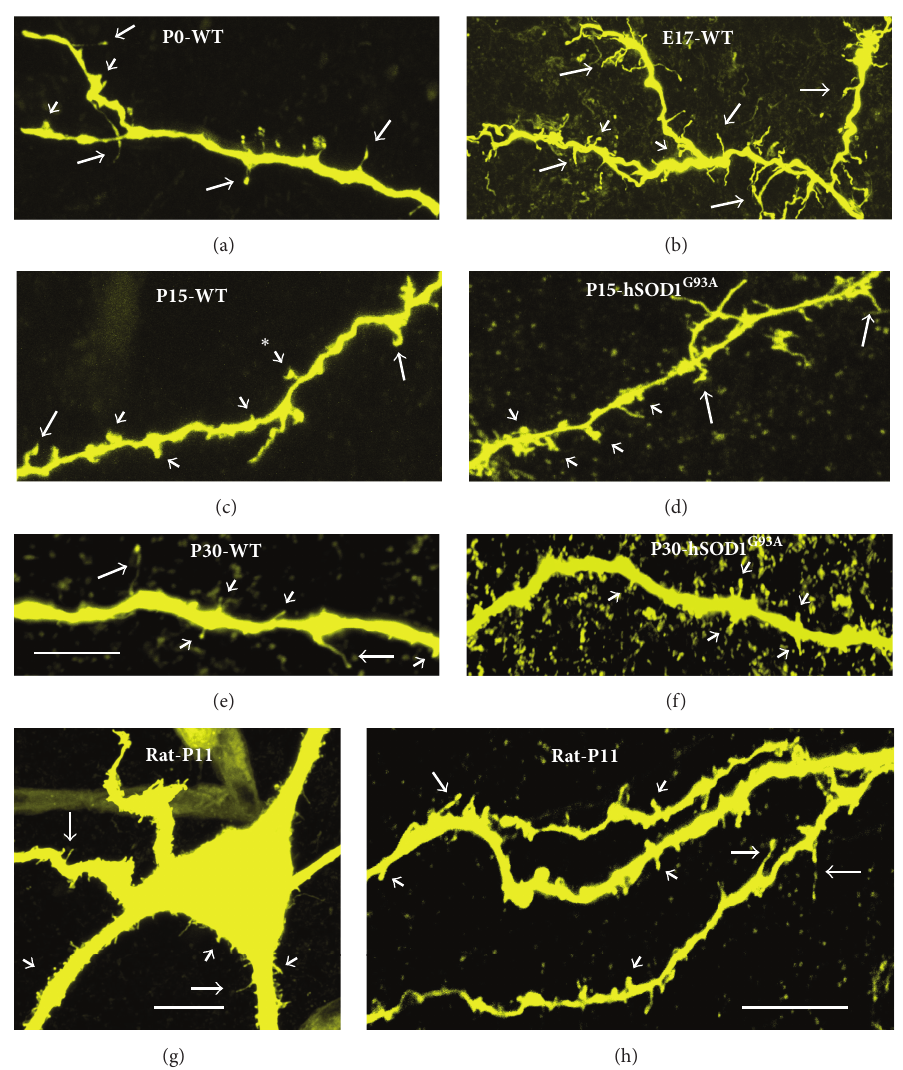
Figure 6: Developmental changes seen in filopodia (long arrows) and spine-like processes (short arrows) in distal dendrites of hypoglossal motoneurons from C57/Bl6 WT mice, Wistar rat (P11; WT), and hSOD 1 G 93 A mutant mice. (a-b) The filopodia were long and common and spine-like processes started to form along the distal dendrites at E17-P0. Long and very dense filopodia were seen in some distal dendrites at late embryonic and newborn mice (b). (c, e) Filopodia density compared to E17/P0 gradually reduced with postnatal maturation at P15 (c) and further reduced by P30 (e) WT mice. Spine-like processes decreased in length becoming gradually stubby shaped with postnatal maturation; spine density increased by P15 (c) but decreased at P30 (e). A rare Y-shaped branched spine is marked with an asterisk ∗ (c). (d–f) Increased density of spine-like processes in mice overexpressing the mutated human SOD 1 G 93 A gene at P15 (d) and P30 (f). (g-h) Similar filopodia and spine distribution were seen in the P11 rat hypoglossal motoneuronal soma, primary (g) and distal dendrites (h). All micrographs are assembled from confocal image stacks of 20 to 40 optical images collected at 0.35 𝜇 m steps. Scale bars in (e), (g), (h) = 10 𝜇 m. Scale bar in (e) applies to panels (a) to